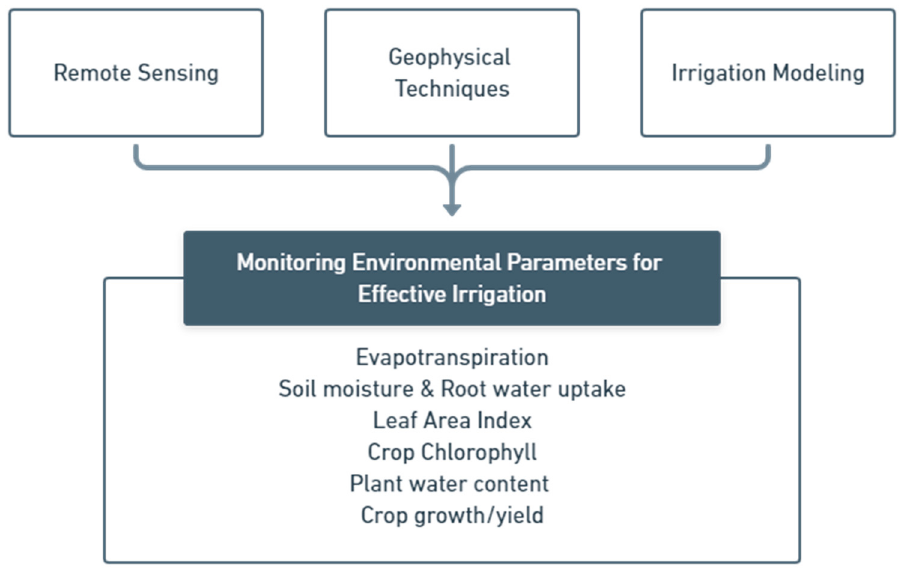
Figure 1. Flowchart of precision agricultural services to support proper irrigation management.